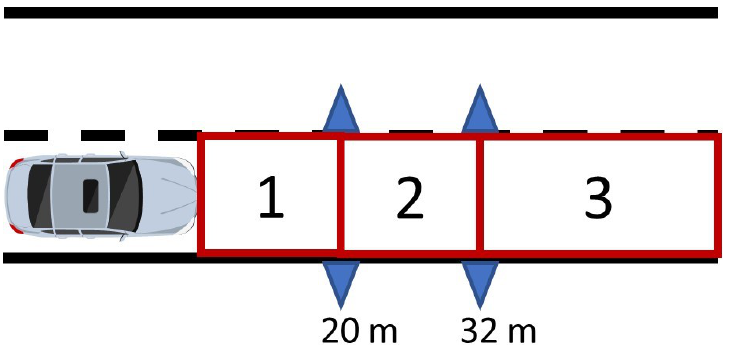
Figure 2. Test arrangement for the static test. Area 1 (near field): 0m–20m, area 2 (mid field): 20m–32m, area 3 (far field): > 32m (to vanishing point of road).